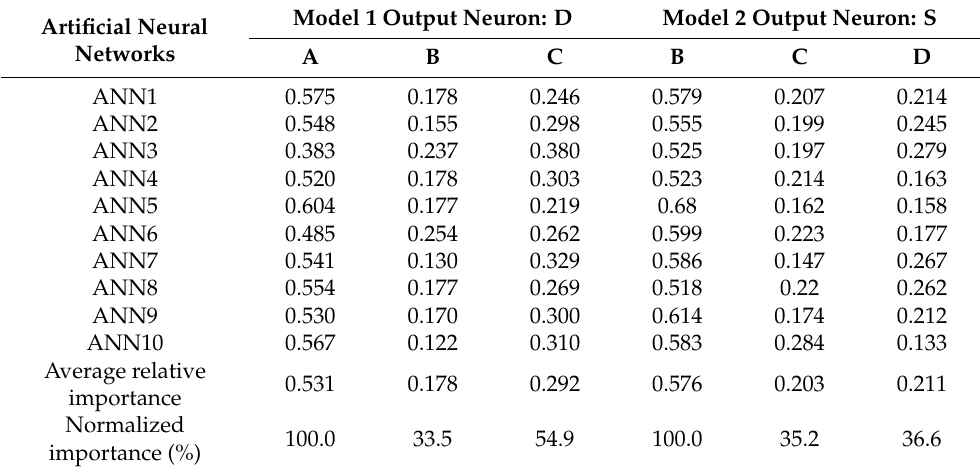
Table 12. Sensitivity analysis of